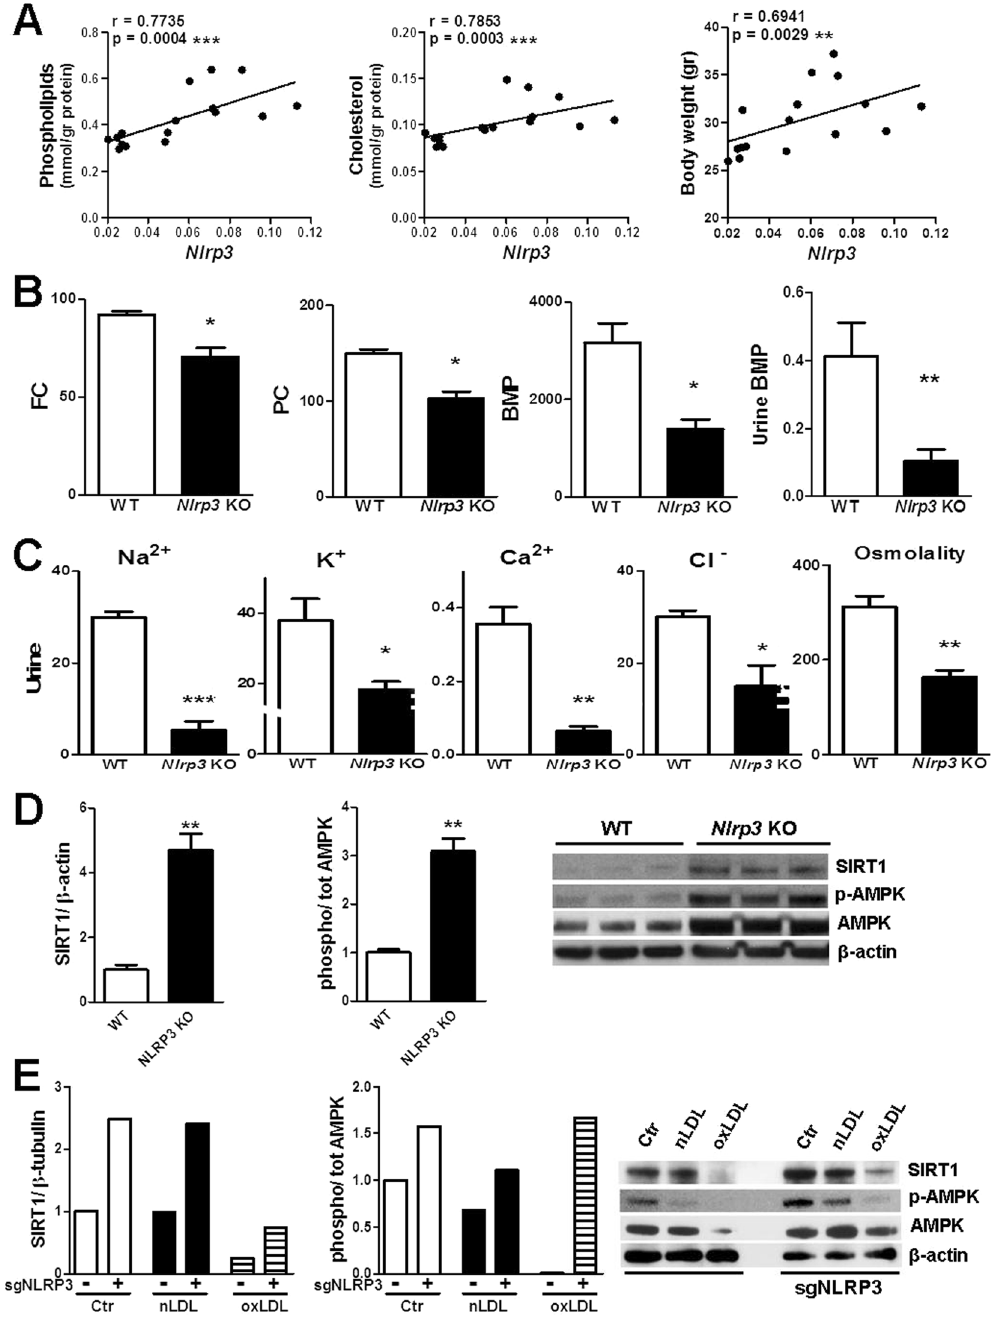
Figure 4. Differential lipid and protein expression in kidneys and cultured tubular cells lacking NLRP3. ( A ) Spearman rank correlation between Nlrp3 renal gene expression and total renal phospholipid content, cholesterol (mmol/gr protein) and mice body weight (gr). WT mice fed a control or Western-diet; n = 16. ( B ) Mass spectrometry analysis of lipid content in kidney tissues and urine from WT and Nlrp3 knockout mice on a Western-cholesterol enriched diet. Renal lipid species normalized for mg proteins: free-cholesterol (FC, nmol/mg protein), phosphatidylcholine (PC, nmol/mg protein), bis(mono)acylglycerol phosphate (BMP, pmol/ mg protein); n = 4. Urine BMP ( µ mol/l) normalized for urine levels of creatinine ( µ mol/l); n = 8. ( C ) Urinary electrolyte concentrations (mmol/l) and urine osmolality (mOsm/kg) normalised for creatinine content (mmol/l); urine samples from WT and Nlrp3 KO mice after 16 weeks of WD; n = 3. ( D ) Westernblot: SIRT1 expression and phosphorylation rate of AMPK in WT/ Nlrp3 KO kidneys of mice on a Western-diet; β -actin used as loading control. Data normalized to the values of WT kidneys; n = 3. ( E ) Westernblot showing the differences in full-length SIRT1 and AMPK activation rate between HK2 cells stably expressing or not sgRNA targeting NLRP3 gene expression after 3 days treatment; β -actin used as loading control. Intensity values normalized to values of control cells transduced with empty vector. Data presented as mean ± SEM; * P < 0.05, ** P < 0.01, *** P <